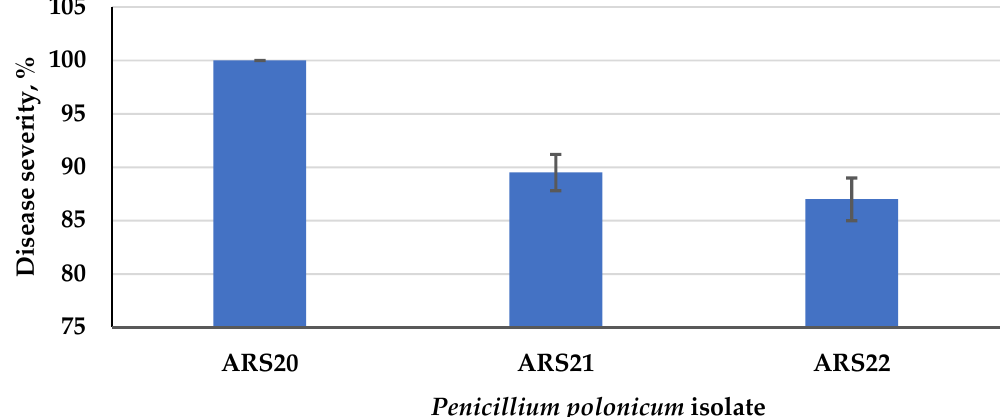
Figure 4. Disease severity of the three tested isolates of Penicillium polonicum on JA tubers.